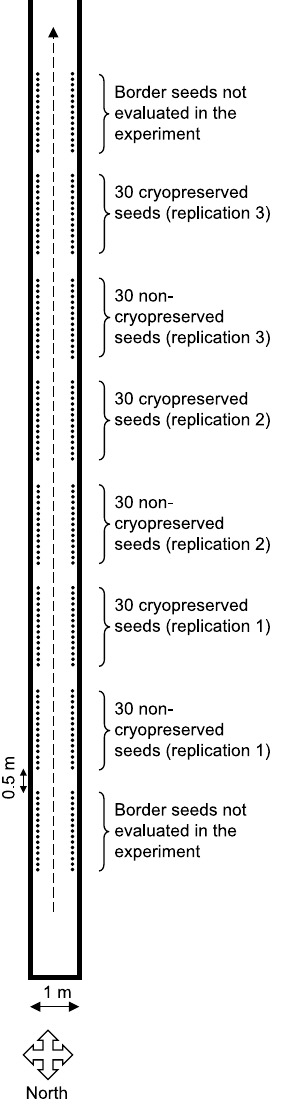
Fig. 1: Superior view of the useful area of the plant bed, made of Ferralytic- red soil and filter-cake-sugarcane ashes (1:1, v:v). Dots symbolize seeds (70 cm × 25 cm apart). The broken arrow in the middle of the plant bed represents the microject irrigation system, which watered the plants for 5 min every 8 h. The plant bed was 50 cm high and its bottom contained a 10 cm-high stones layer to facilitate drainage.